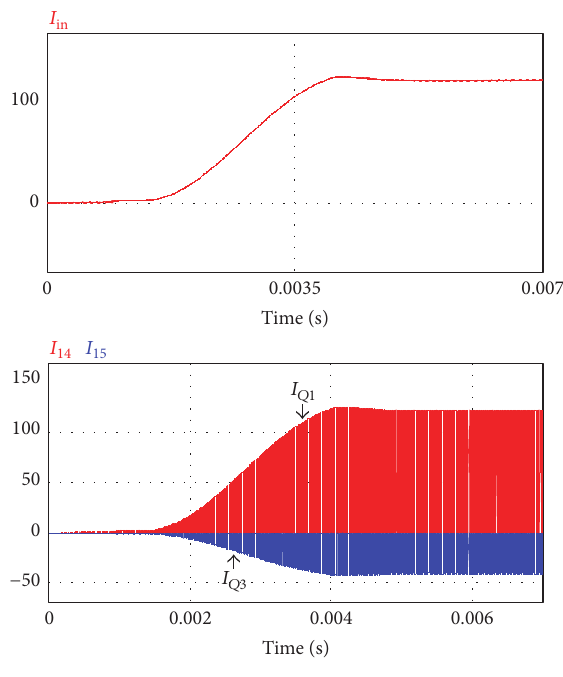
Figure 8: Low-voltage side current waveform and MOSFET current of soft start.